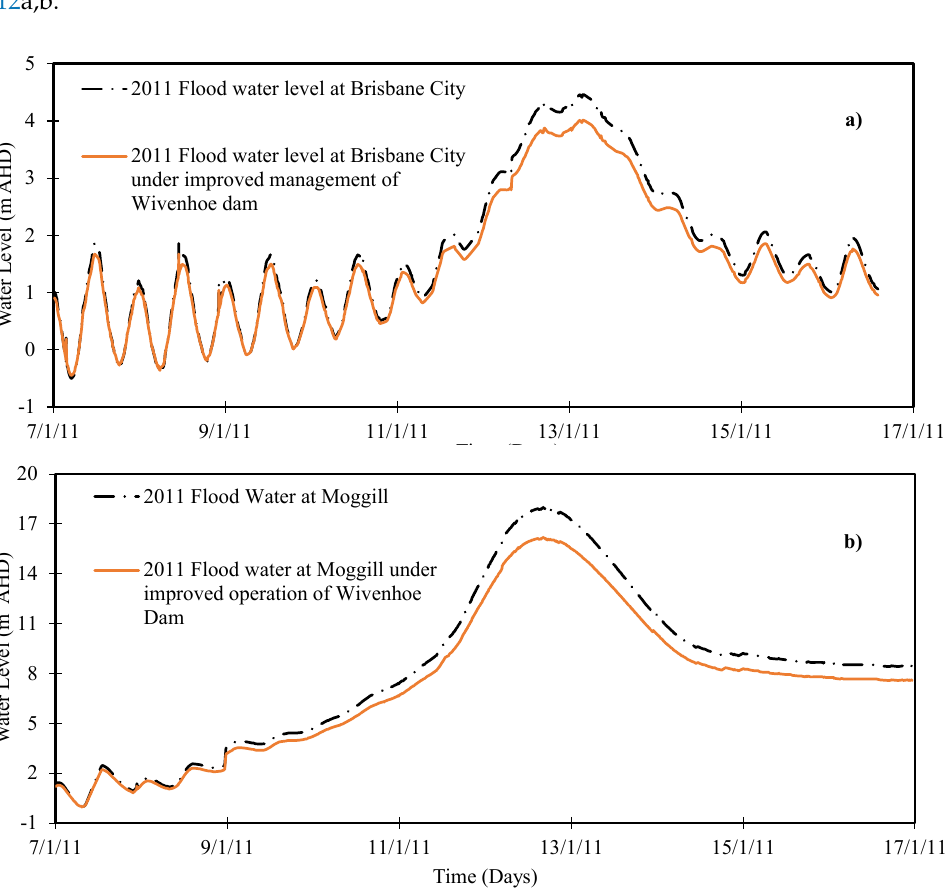
Figure 12. Comparison of water levels at ( a ) Brisbane city gauge and ( b ) Moggill under improved management of Wivenhoe dam [53].